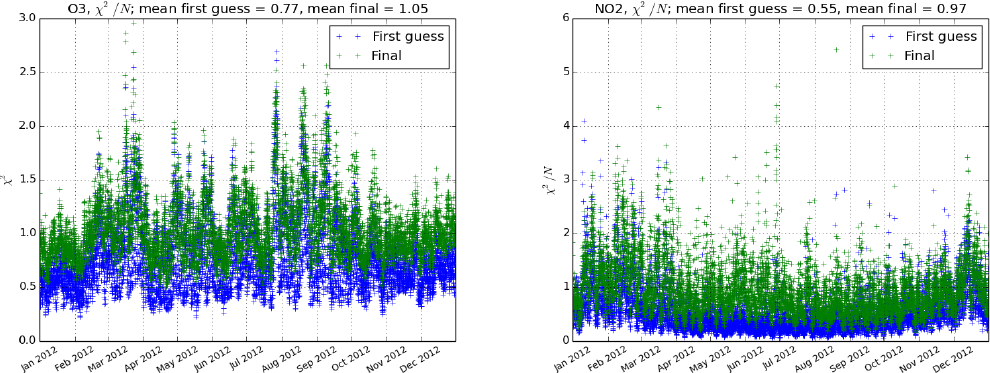
Figure 5. The χ 2 /N obs consistency indicator for hourly analyses of O 3 (left) and NO 2 (right). The values in blue and green are shown for the first guess and final assimilation setups, respectively. Note the different scales for O 3 and NO 2 .